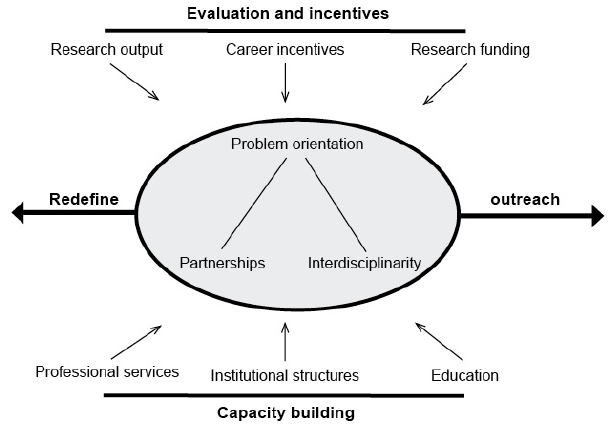
Fig. 2. Creating an enabling environment for